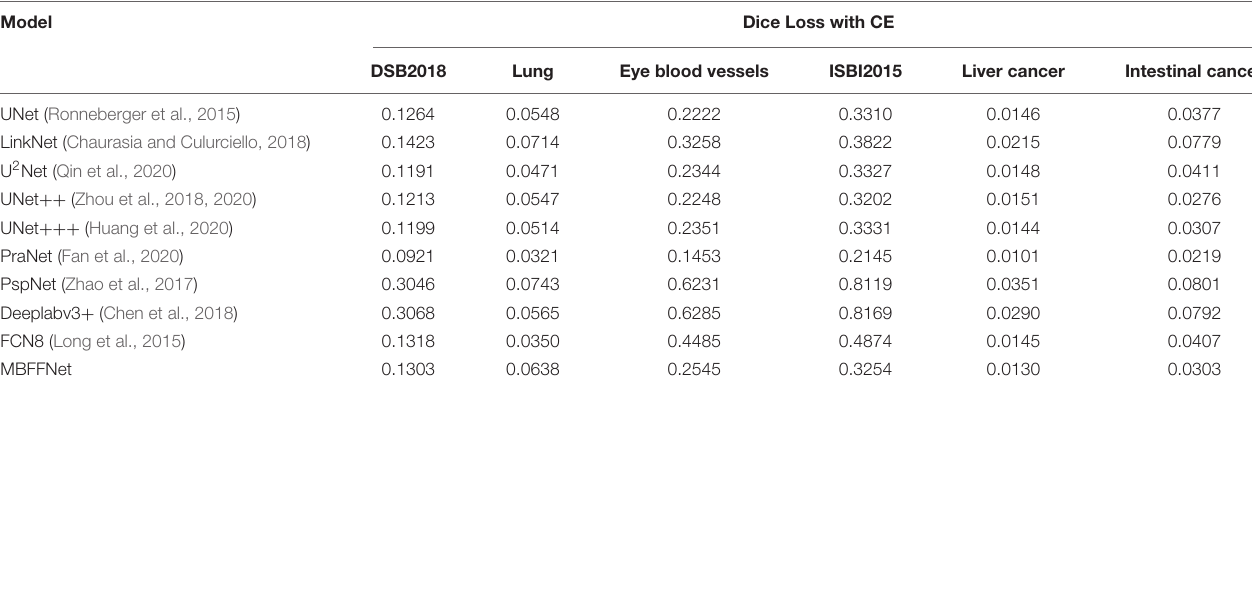
TABLE A3 | Dice loss with CE evaluation index for multi-class medical image